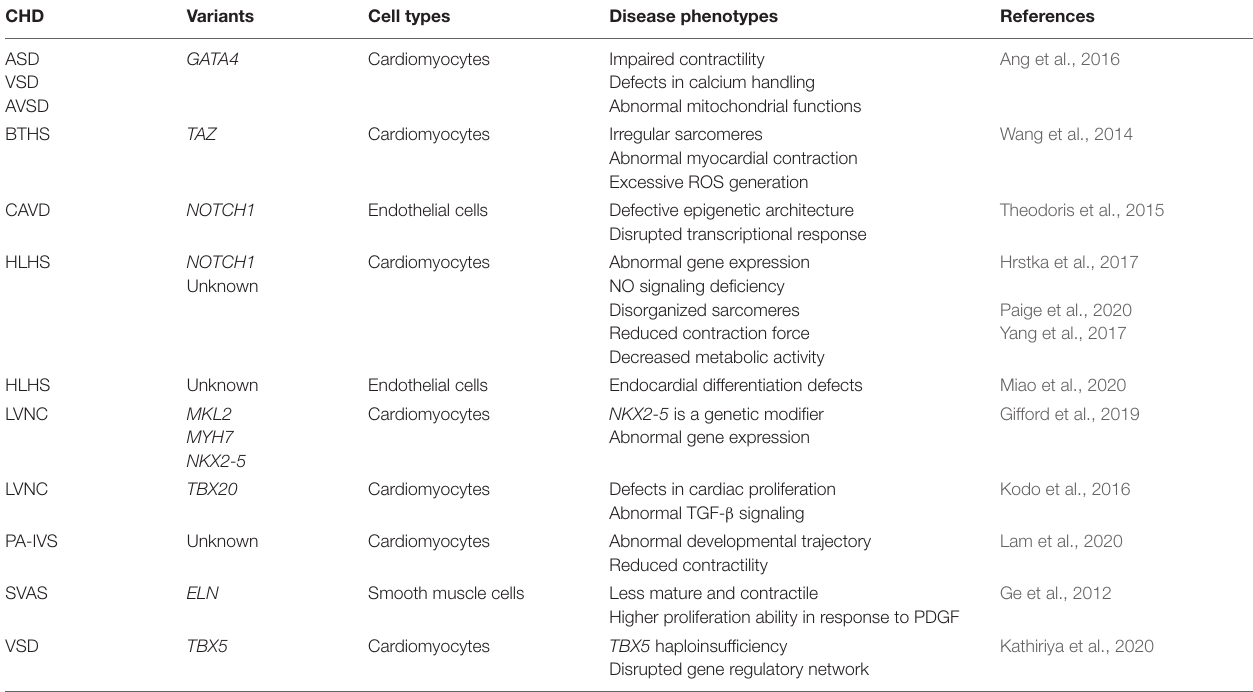
TABLE 2 | Current iPSC models for studying disease mechanisms of